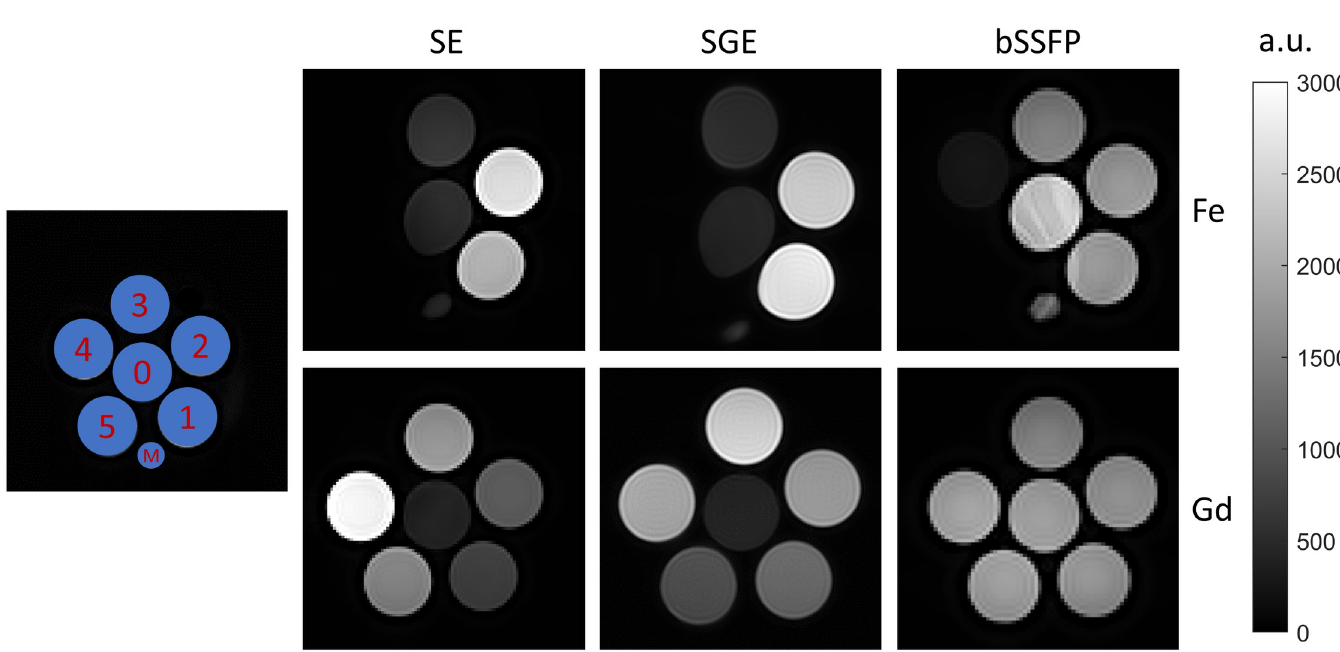
Fig 1. Setup of the CA phantom (left) for both ferumoxytol (upper row; Fe) and gadoterate (lower row; Gd), with 0 = reference (no CA), 1 = 0.15 mM, 2 = 0.3 mM, 3 = 1.2 mM, 4 = 7 mM, 5 = 14 mM. ‘M’ indicates the marker for orientation. MRI scans of the SE (middle left), SGE (middle right), and bSSFP (right) sequence show the amount of signal compared to the reference sample which is in the center of the setup. Deformation of the reference sample can be seen in the SE and SGE scans of ferumoxytol. Due to scaling only images made with the same sequence can be compared with respect to signal intensity.